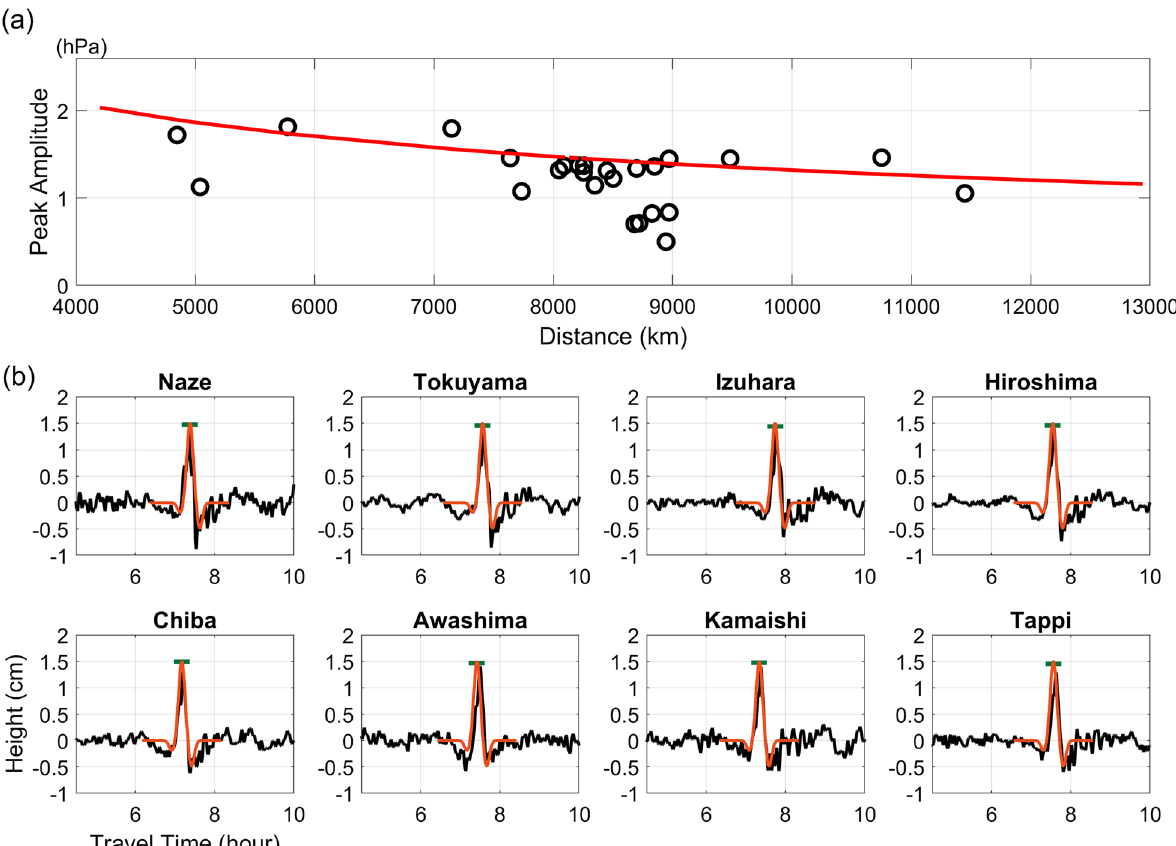
Fig. 1 a The black circles represent the peak amplitude of the observed air pressures relative to the distances between the barometers and the Tongan volcano. The red line is the regression line of the peak amplitude developed by applying the attenuation relationship h A = h 0 R − 0.5 , where h 0 is assumed to be 132 hPa, and R is the distance from the source. b The black and red lines display the observed and simulated air pressures in Japan. The green bars indicate the peak amplitude estimated by the regression. The station locations are shown in Additional file 1: Fig.